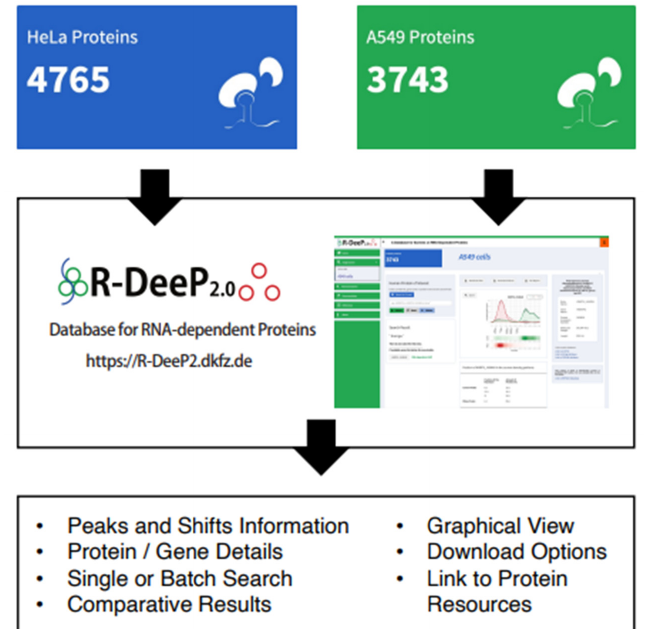
Figure 7. R-DeeP Database 2.0: The R-DeeP 2.0 database provides information on R-DeeP results on 4765 proteins in HeLa S3 cells and 3743 proteins in A549 cells at https://R-DeeP2.dkfz.de [22]